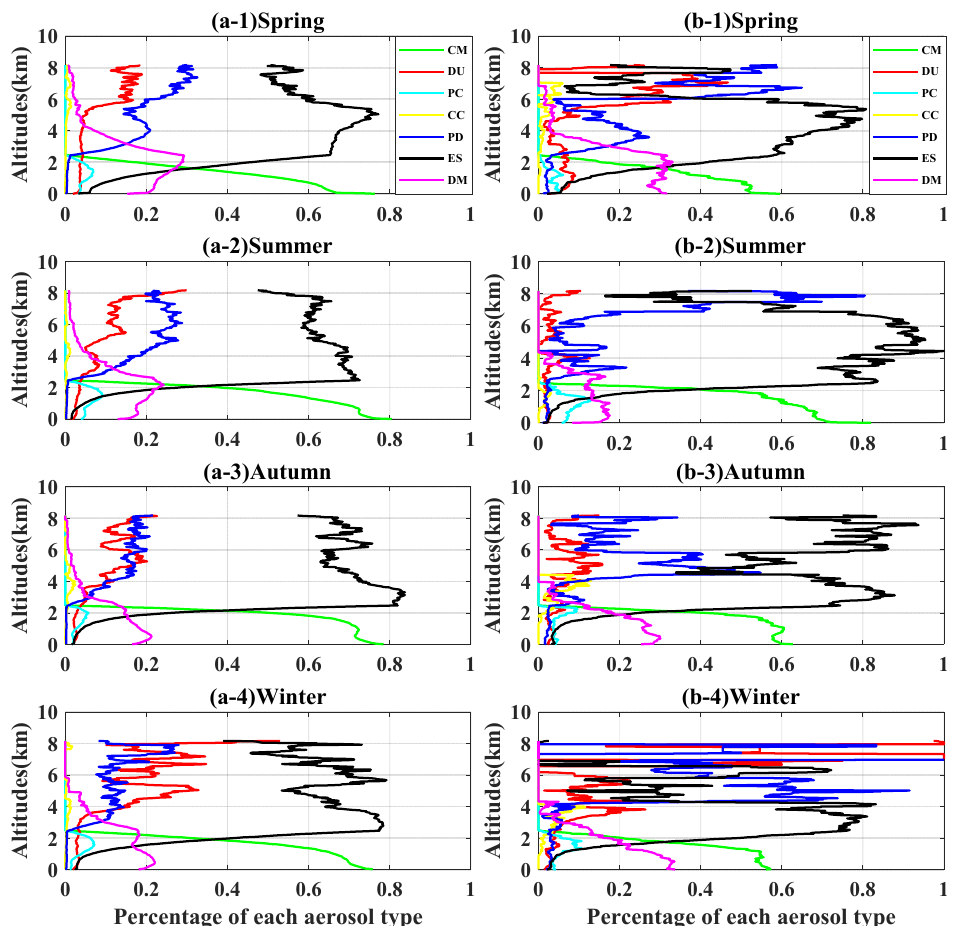
Figure 5. Vertical distributions of percentages of the 7 aerosol types over the NSCS ( a-1 – a-4 ) and the coastal waters of the GBA ( b-1 – b-4 ).